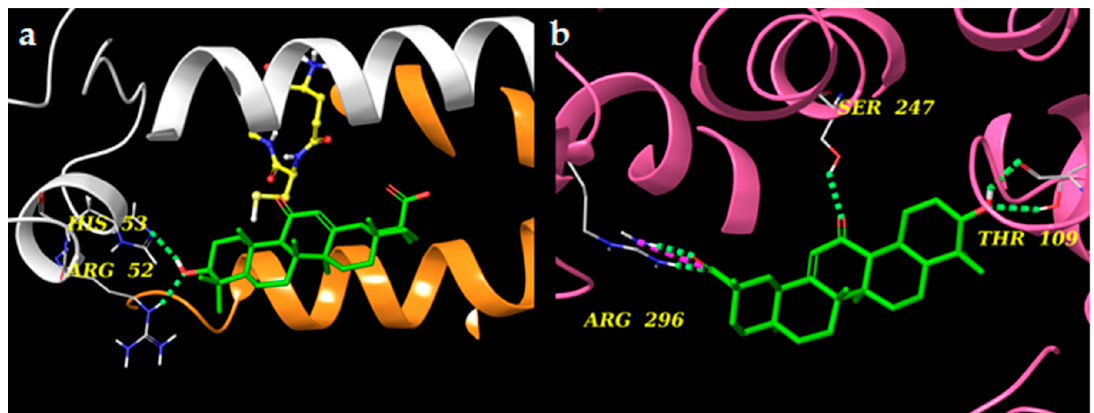
Figure 9. ( a ) 3D models of AG (colored by atom types: C green, O red, polar H white) in the binding site of microsomal prostaglandin E synthase 1 (mPGES-1) (panel a, chain A and chain B are reported in orange and white ribbons, respectively) and ( b ) microsomal prostaglandin E synthase 2 (mPGES-2) (chain A is reported in pink ribbons). Green dotted lines represent H-bonds and pink dotted lines represent salt bridges .